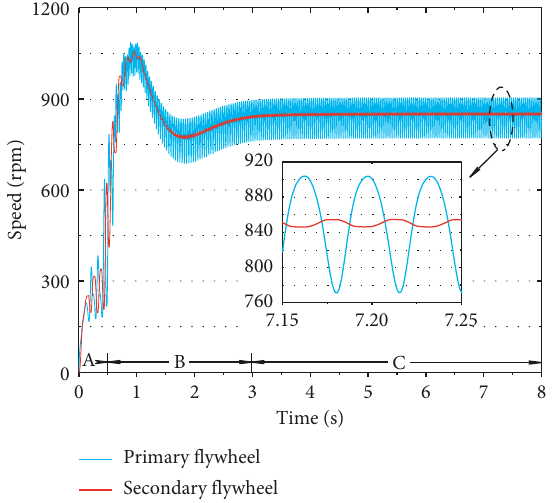
Figure 7: Simulating speed fluctuation.